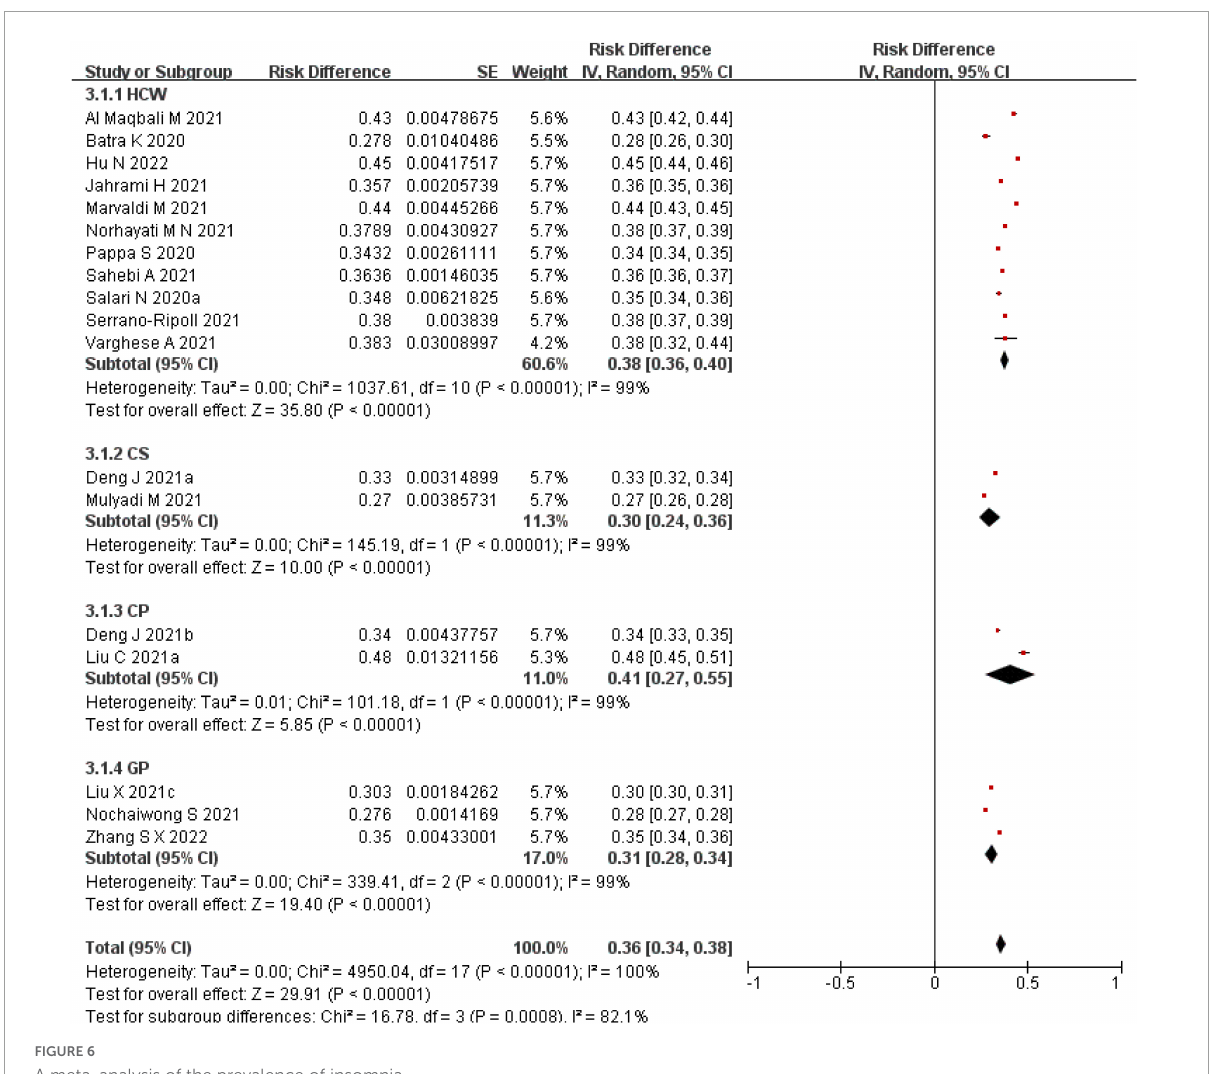
FIGURE6 A meta-analysis of the prevalence of